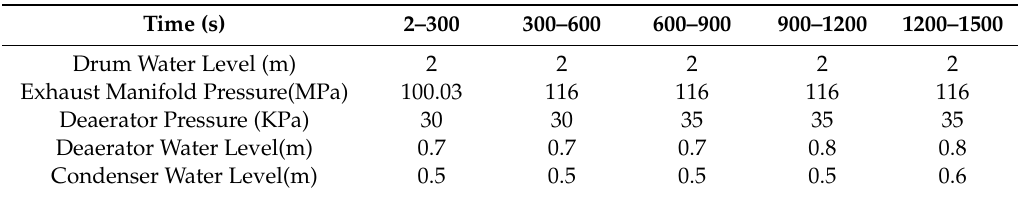
Table 3. Step setpoints changes in the